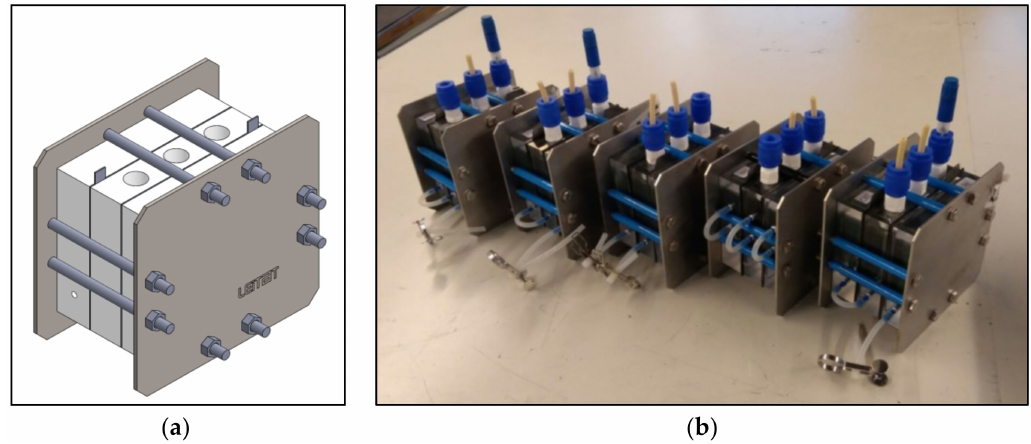
Figure 3. ( a ) The design and ( b ) photos of the constructed EMG-BES